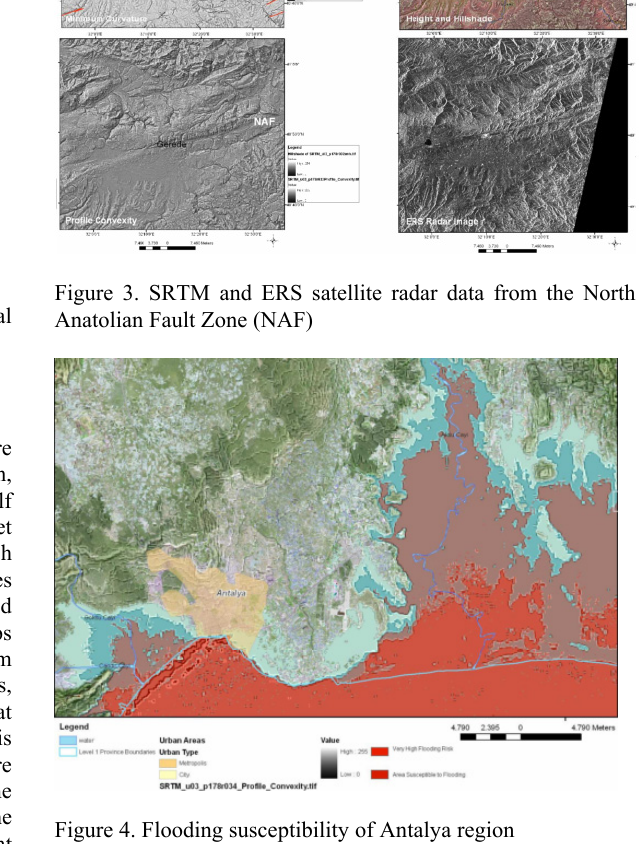
Figure 4. Flooding susceptibility of Antalya